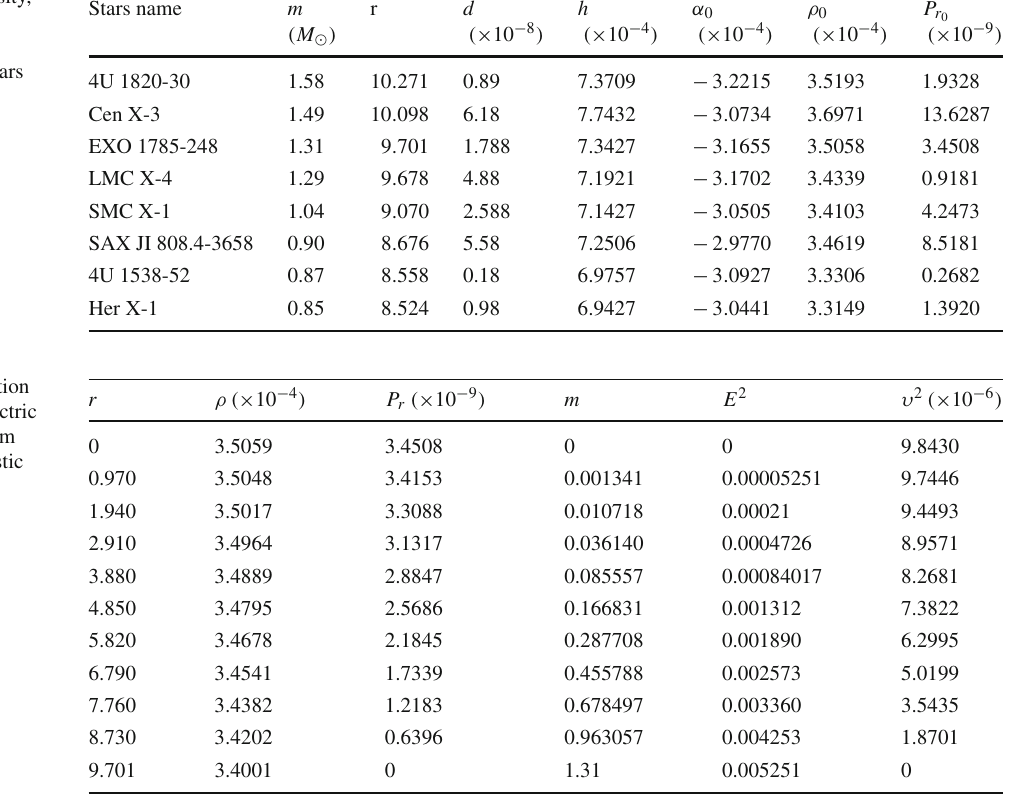
Table 1 Mass, central density, central radial pressure and radiation density (cid:8) = 7 . 5756 × 10 − 16 , for stars